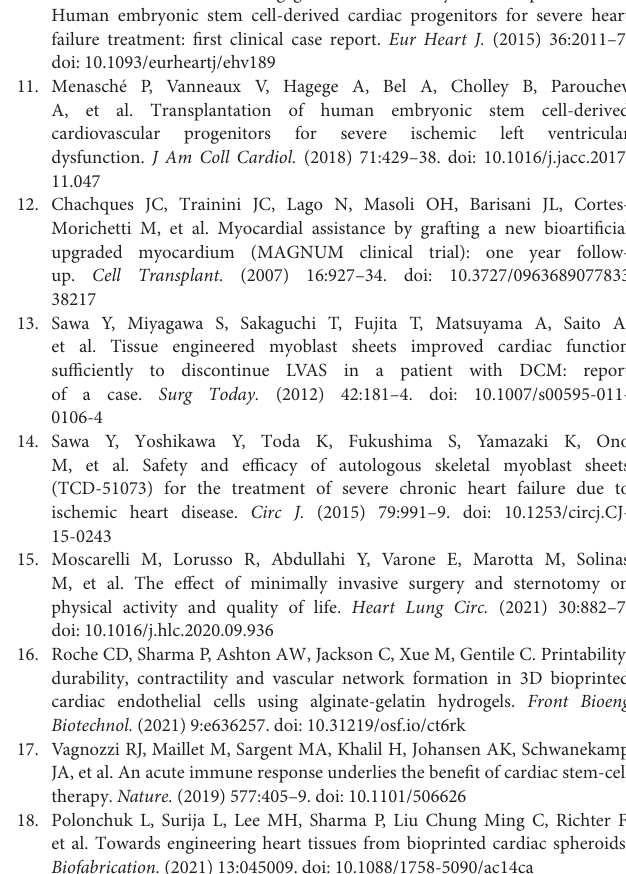
Supplementary Figure 1 | The instrument with the sheath covering the distal arms removed. Frontal (A) and trimetric (B) views show the instrument with arms in the infolded position. Supplementary Figure 2 | Control pathways linking the operator’s end to the distal arms. (A–C) Highlighted views of the three Grips controlling the distal arms. Supplementary Figure 3 | Mechanism allowing for adjustment of the rotational angle of the arms. Infolded arms (A) can be outfolded to open position and rotated individually by the grips shown in (B) . View shown in (A) is the distal (patient’s end) and (B) shows a “top down” view of the proximal (operator’s end) of the instrument (looking down onto the Grips). Supplementary Figure 4 | 3D printing parameters for the resin sizing and learning prototyping of individual parts. Supplementary Video 1 | Video walkthrough of patch delivery device, including background and mechanistic demonstration from the computer-aided design